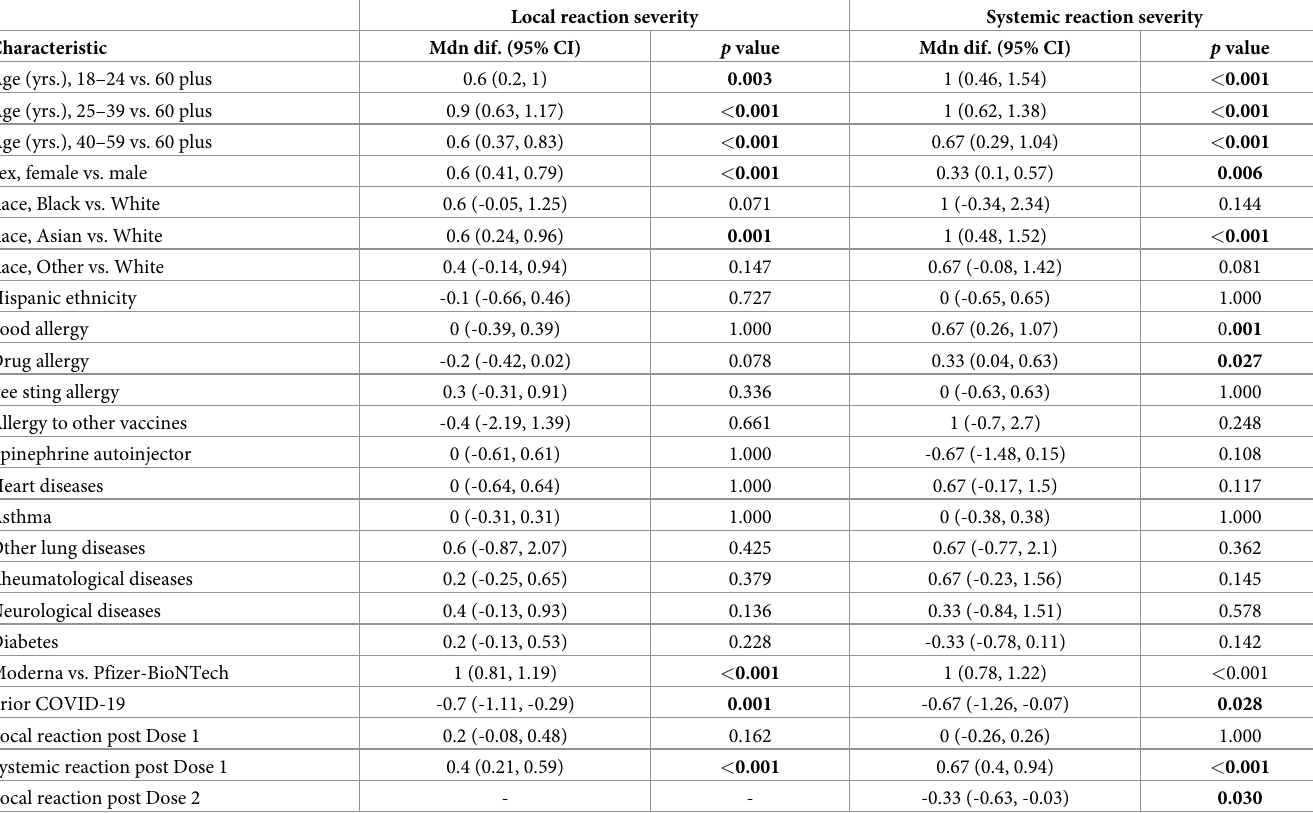
Table 7. Factors associated with the severity of local and systemic reactions after the second dose of the COVID-19 vaccine.